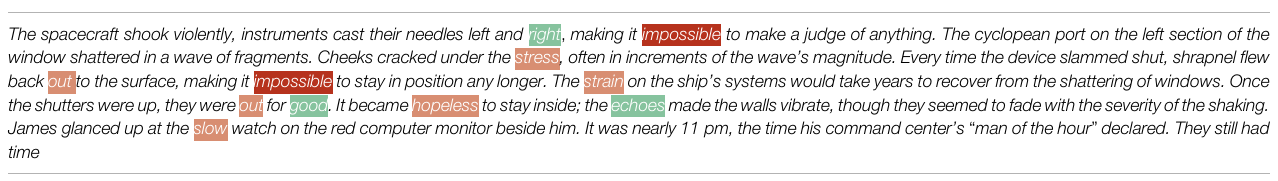
TABLE 13 | Example stories generated with medium positive sentiment steering.